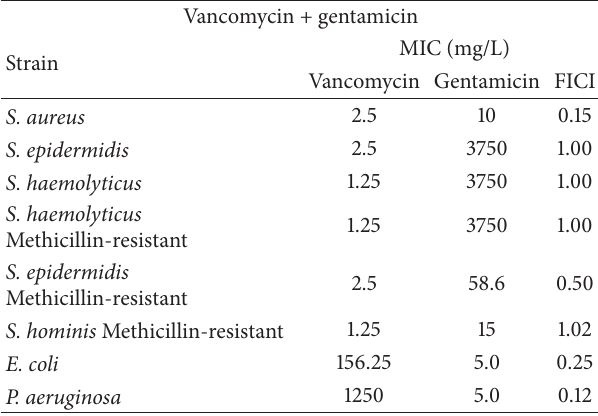
Table 1: Invitro activity of gentamicin and vancomycin in combina- tion against multiresistant clinical